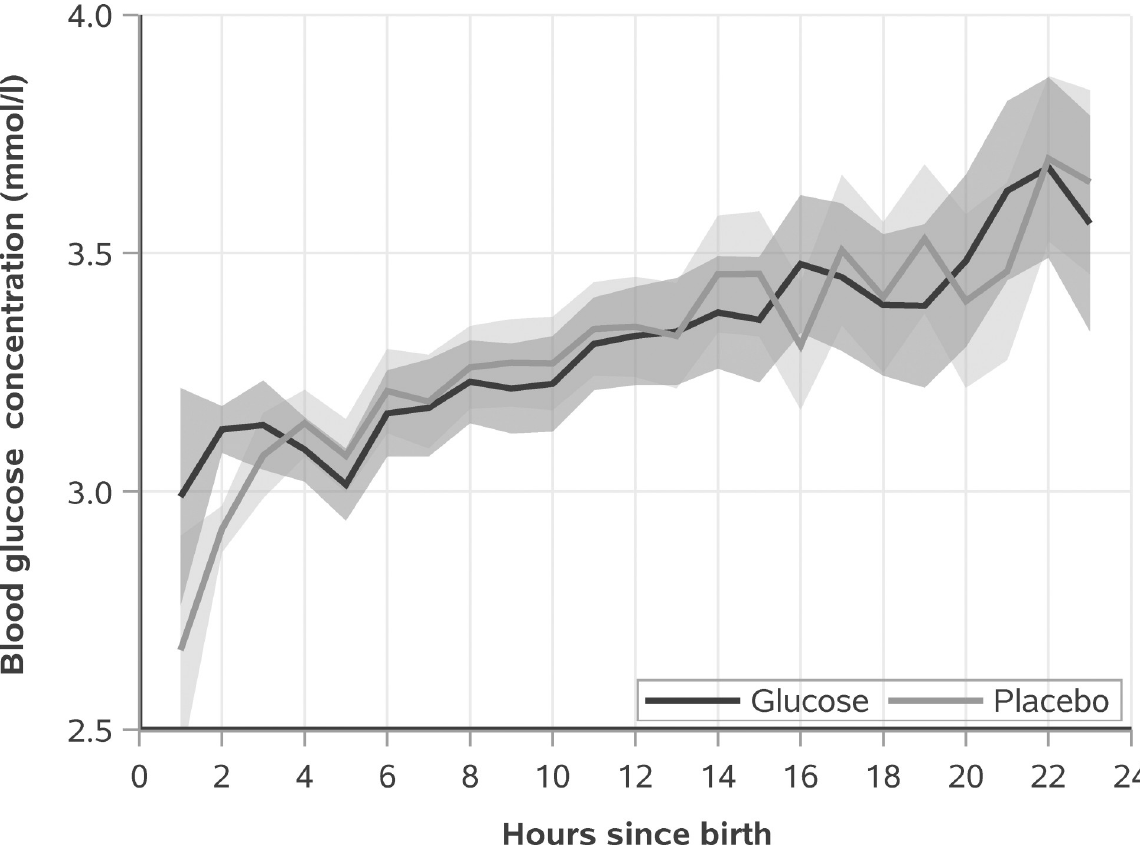
Fig 4. Blood glucose concentrations (mean and 95% CI) over the first day for the dextrose gel and placebo groups. Time is rounded into hour bins. Glucose concentrations are different between groups at 2 hours ( p < 0.01).